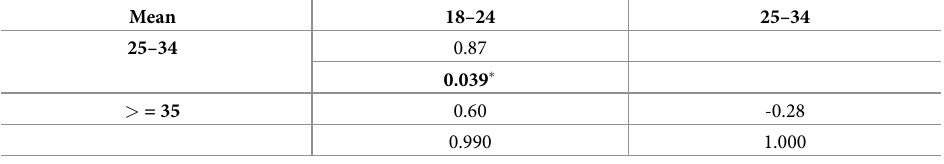
Table 7. Pair-wise comparisons of total protein with categorized age using post hoc tests